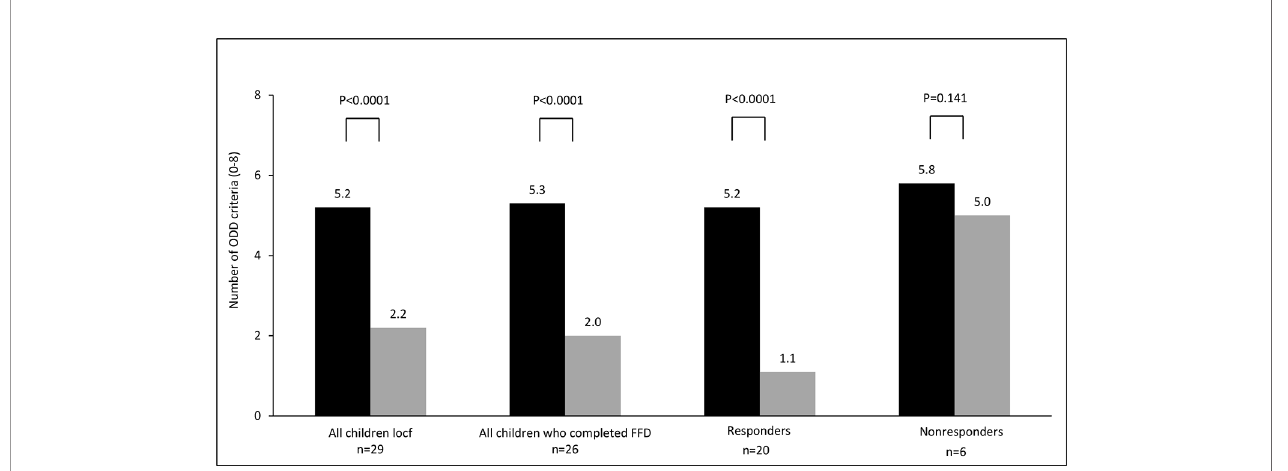
FIGURE 4 | Number of oppositional de fi ant disorder (ODD) criteria (0 – 8) at T1 (black bar) and T2 (grey bar). Locf, last observation carried forward; FFD, few-foods diet; responder, at least 40% improvement; non-responder, no or less than 40%